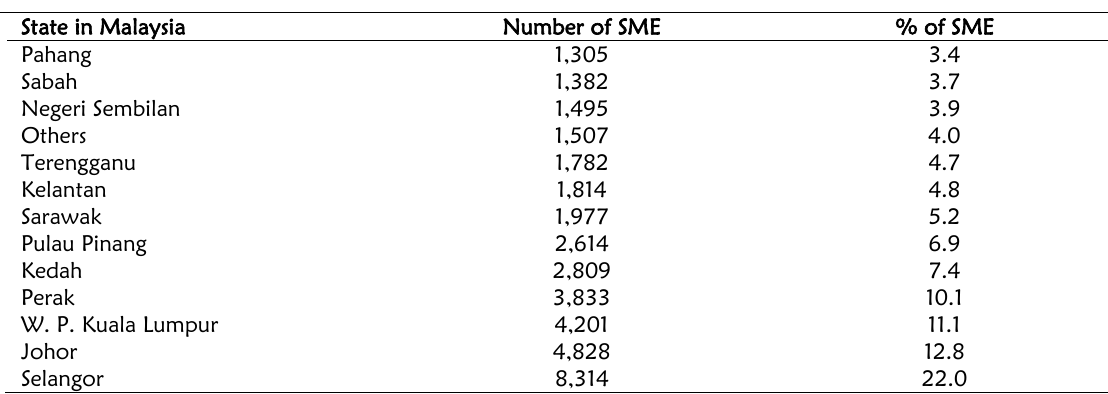
Table 3: SMEs in the manufacturing sector by state (Economic Census,